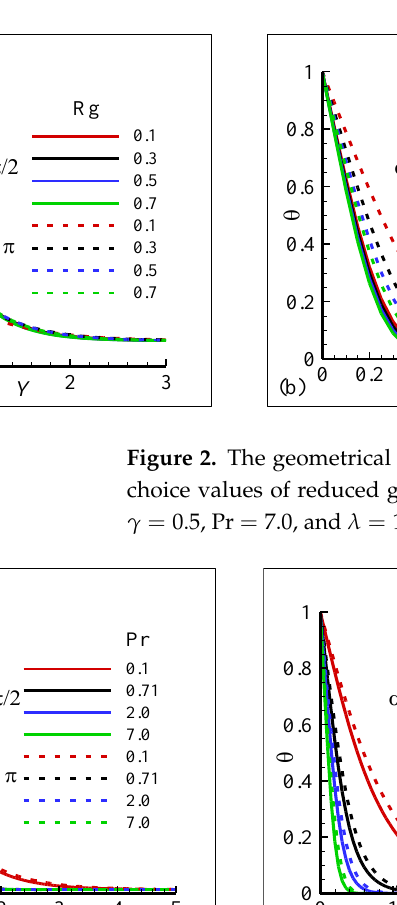
Figure 3. The geometrical representation of ( a ) 𝑈 , ( b ) 𝜃 and ( c ) 𝜙 at 𝜋 2⁄ and 𝜋 positions with four choice values of Pr = 0.1,0.71,2.0 and 7.0 with some fixed parameters 𝛾 = 0.7 , 𝜉 = 0.8 , Pr = 7.0 , and Rg = 1.7 .